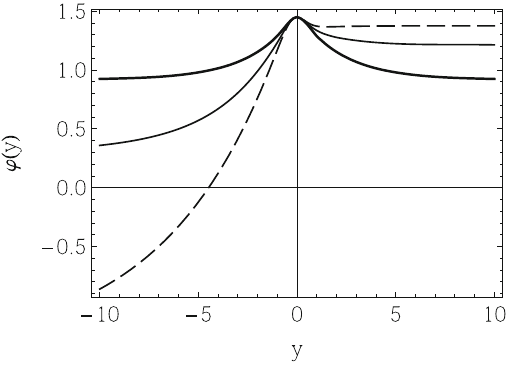
Fig. 18 The field ψ( y ) given by Eq. (43) depicted for ψ 0 = − 1 and c = 0 (thick solid line), c = 0 . 2 (thin solid line) and c = 0 . 4 (dashed line)